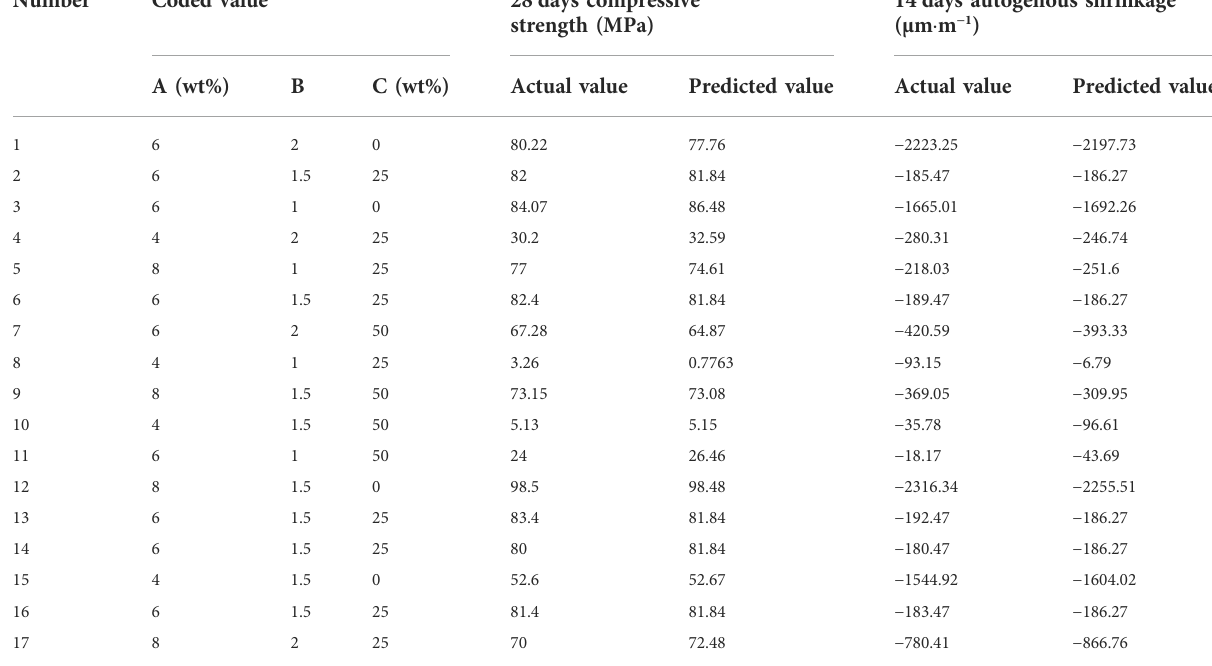
TABLE 3 RSM design and test results of